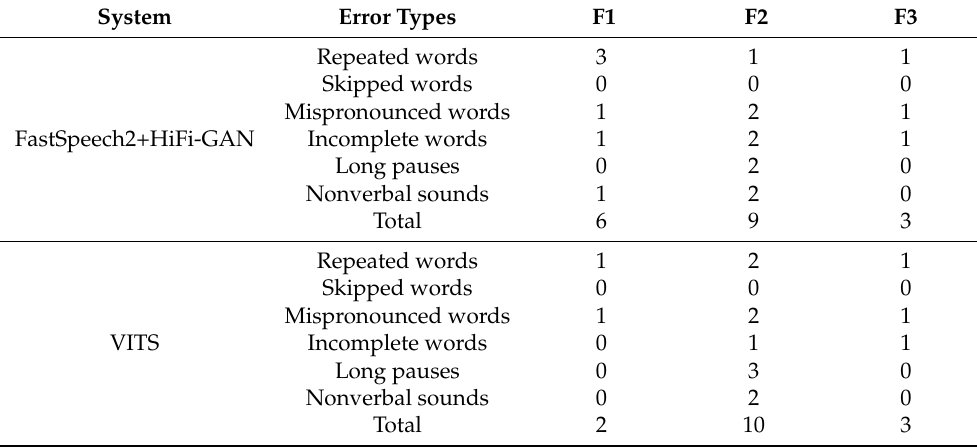
Table 4. Error types found in the 50-sentence test set (Total number of words is 500).